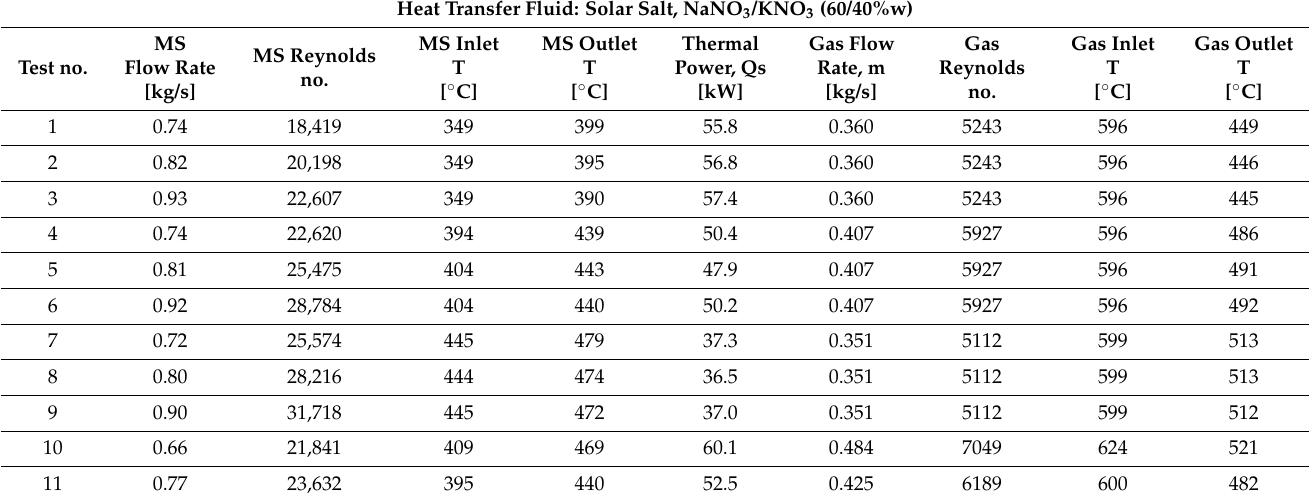
Table 2. Experimental results obtained with the MSH prototype powered with LPG (except for test no.11 when a biogas-like mixture was used) and the solar salt as